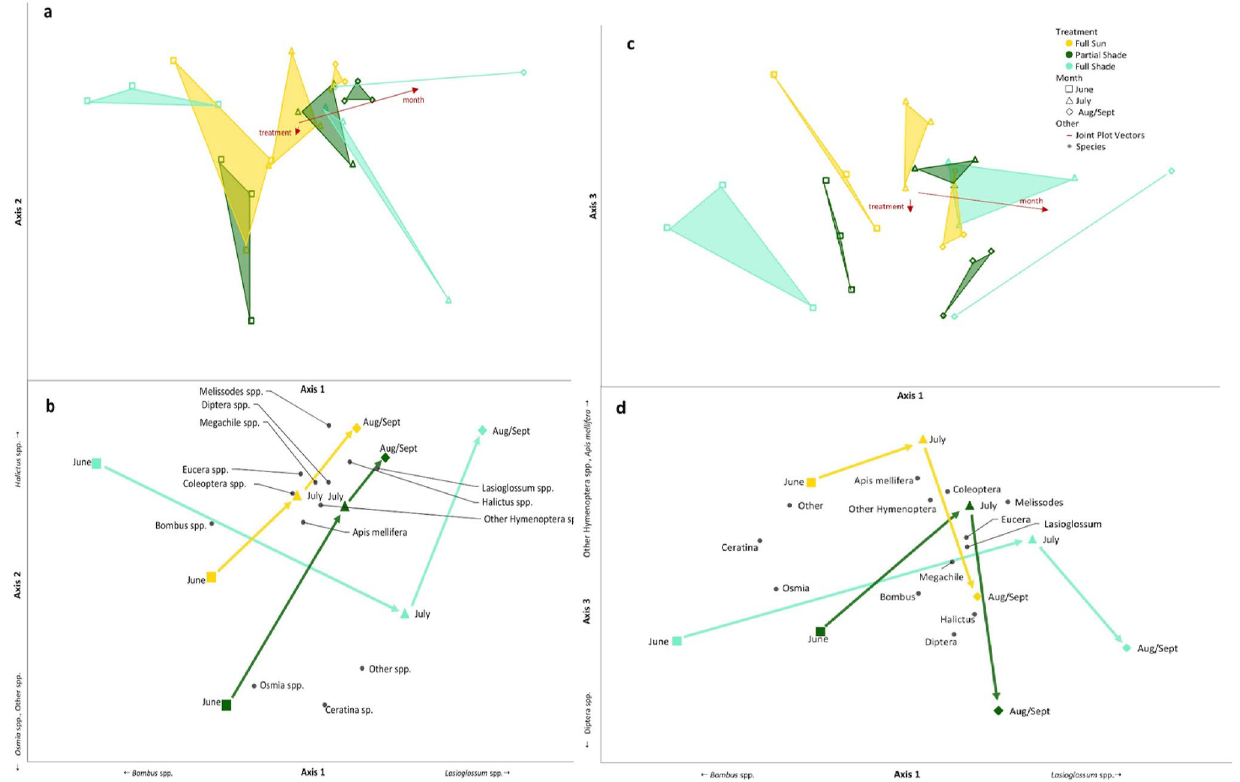
Figure 7. Insect community composition described through a nonmetric multidimensional scaling of sample units (averaged by month) in insect species space, with weighted average positions shown for species significantly correlated with ( a , b ) axes 1 and 2 and ( c , d ) axes 1 and 3. Sample units that are close together in the graph are more similar (in species composition) than those far apart. ( a , c ) Convex hulls connect groups of treatments (by month). Colored, un-filled symbols represent sample units. Black circles represent species. Joint-plot vectors (red lines) show environmental variables correlated with the axes, vector length represents correlation strength. ( b , d ) Successional vectors connect centroids from each group of treatments (by month) to illustrate community change over time. Colored, filled symbols represent centroids. Black circles represent species. Fundamental coordinates were generated and data exploration was conducted in PC-ORD Software version 7.07 47 . Figure linework and aesthetics were created in Microsoft PowerPoint